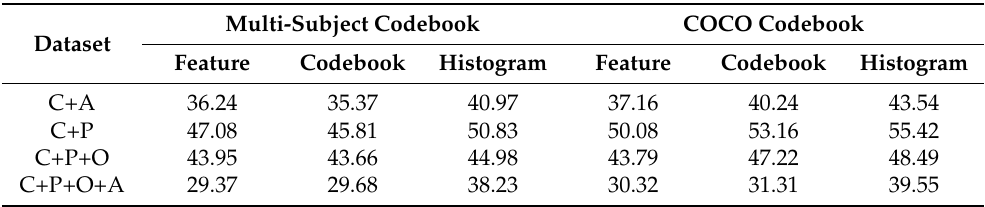
Table 4. The ablation study of codebooks generated using Mutli-subject and COCO datasets.